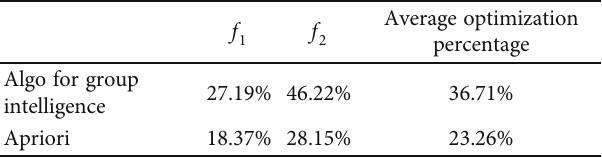
Table 2: Group intelligence